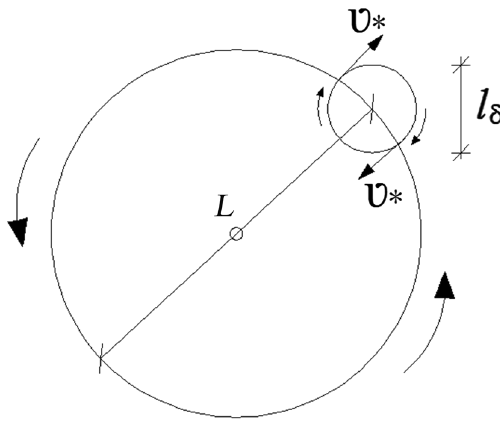
Fig. 4 Scheme for the formation of a turbulent mole (planetary mech- anism of vortex